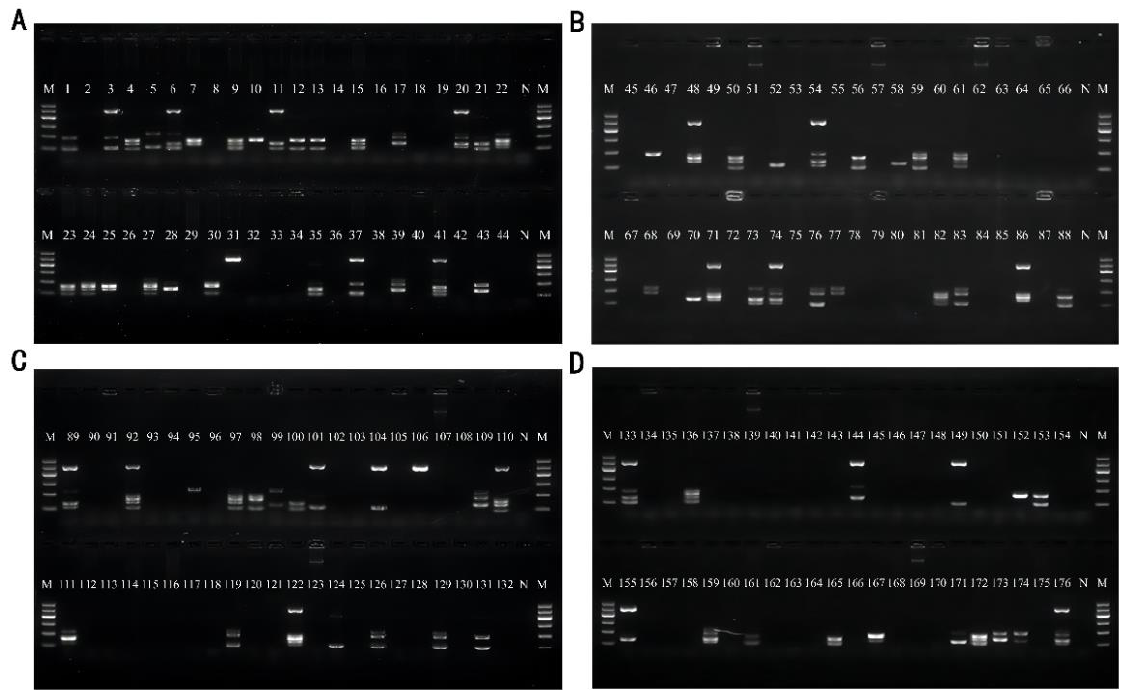
Figure 8. Results of artificial contamination of samples. Lane M: DNA marker B 600; Lane N: Negative control group without the addition of DNA template for amplification. ( A ) Sample basa catfish for Lane 1–22 and sample beltfish for Lane 23~44; ( B ) Sample River shrimp for Lane 45~66 and Sample Sea shrimp for Lane67~88; ( C ) Sample scallops for Lane 89~110 and Sample oysters for Lane 111~132; ( D ) Sample seaweed for Lane 133~154 and Sample skunk cabbage for Lane 155~176. Except for the sample skunk cabbage, the sensitivity test results showed that the artificially contaminated sample detection limit was 10 4 CFU/mL, and the above results are presented in Table 5. Moreover, the overall detection rate was 100% after the statistical analysis. Table 5. Contamination of samples.